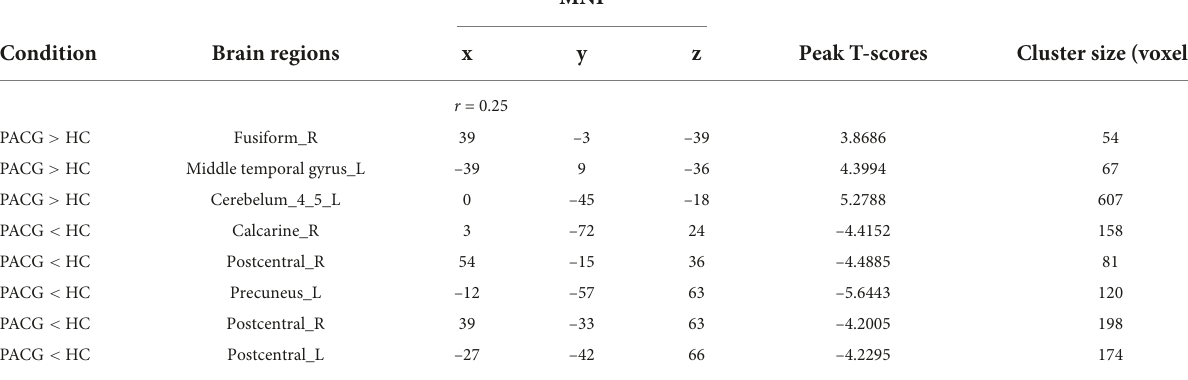
TABLE 4 Significant differences in the DC between the two groups ( r = 0.25).